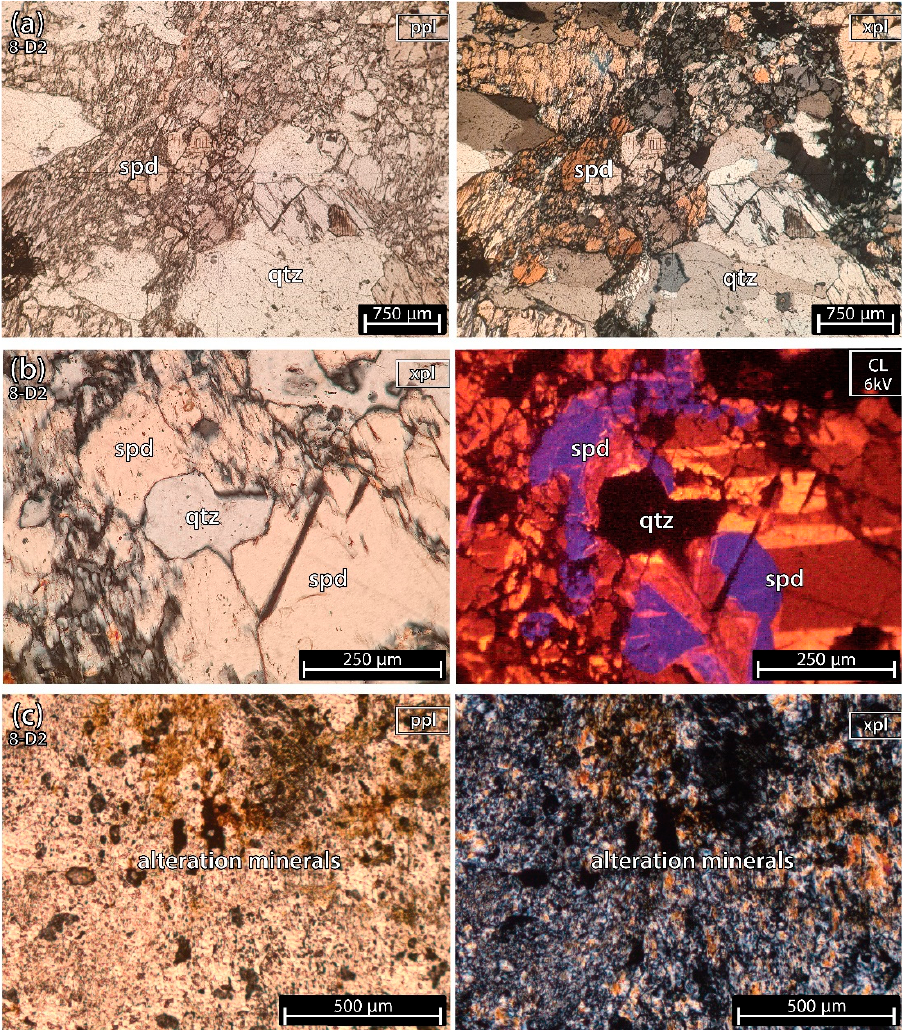
Figure 9. Microphotographs from a fragment of a mixture of spodumene (spd) and quartz (qtz) sample 2 of the aplite-pegmatite 8 (8-D2), also known as 59-AL-52. ( a ) parallel polarized light (ppl) and crossed polarized light (xpl). ( b ) xpl and cold cathodoluminescence (CL) microscopy (CL). This sample is almost all pure spodumene and quartz, except for a small portion of alteration minerals composed of clays and micas ( c ). In cold-CL microscopy, at 6 kV, spodumene has three main colors: yellow, orange and purple. All three colors have a similar strong luminescence. The quartz looks black next to the strong luminescence of spodumene.